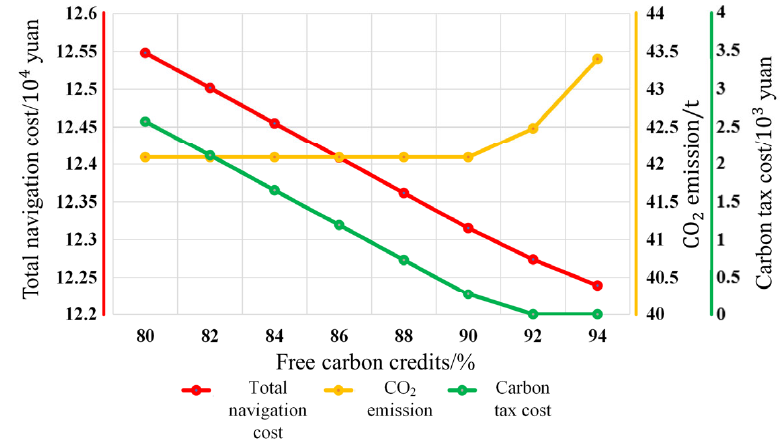
Figure 20. Carbon tax costs under different free carbon credits.